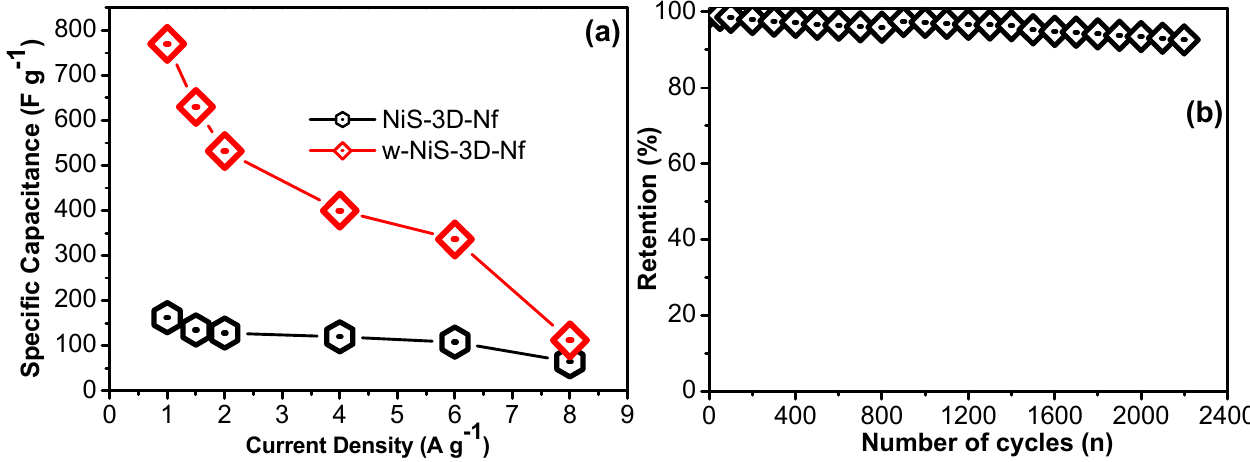
Figure 6. ( a ) Calculated specific capacitance of the NiS-3D-Nf and w-NiS-3D-Nf electrodes at different current densities and ( b ) cyclic stability graph of the w-NiS-3D-Nf electrode at a fixed current density.